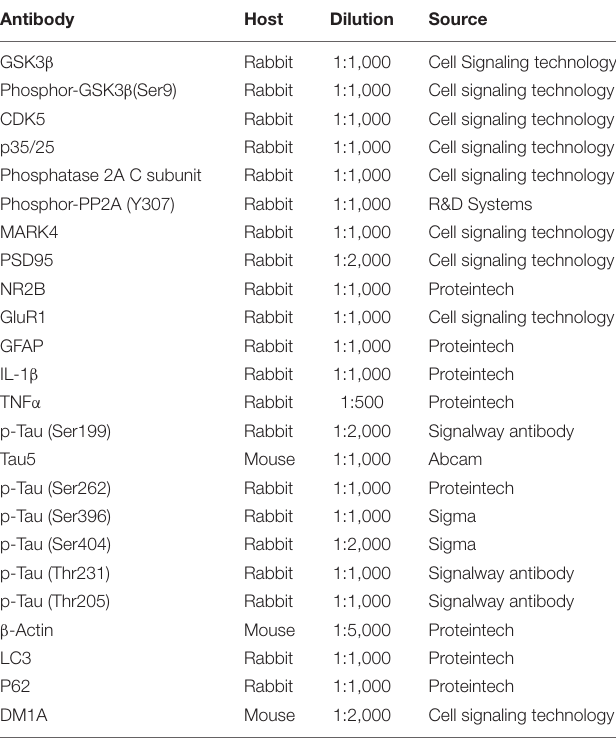
TABLE 1 | The following primary antibodies were used for western blotting.